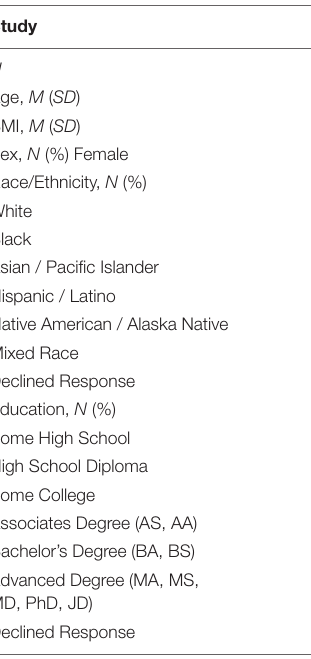
TABLE 1 | Participant characteristics for all